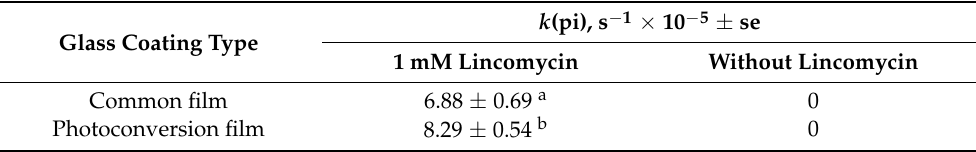
Table 1. Rate constants of photoinhibition (k(pi)) in tomato leaves under common and photoconver- sion films. The data are the means of at least three